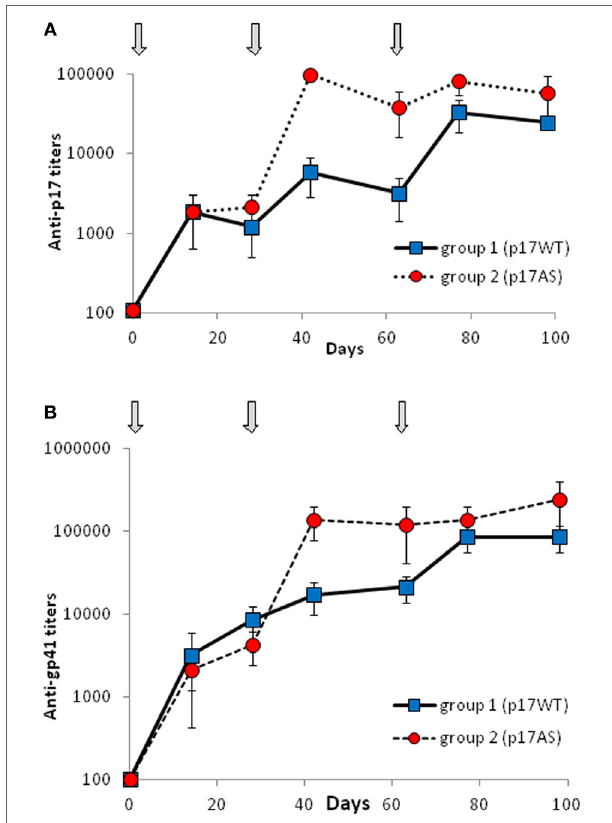
FigUre 3 | Immunization follow-up. (a,B) Serum titration of New Zealand White rabbits immunized by p17WT (blue squares, plain line) or p17AS (red circles, dotted line) against (a) the immunizing p17 protein and (B) recombinant gp41 protein (HXB2 strain). Gray arrows indicate the dates of immunizations. Each value represents the mean of the titers of sera from the three rabbits of each group, measured individually in duplicate. Error bars represent the SD of the same measures.